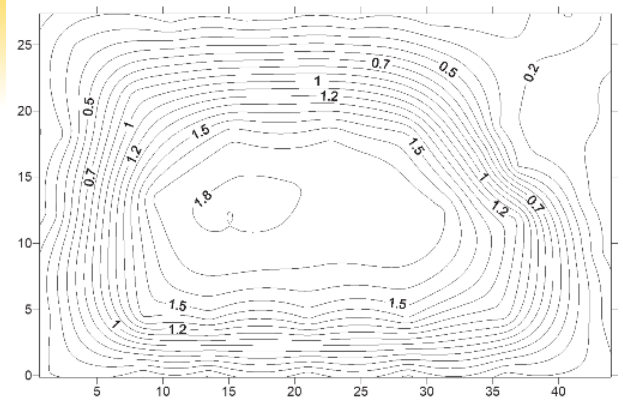
Figura 12 Curvas iso-recalques da 6 a etapa, com interação solo-estrutura, considerando fluência e retração (em